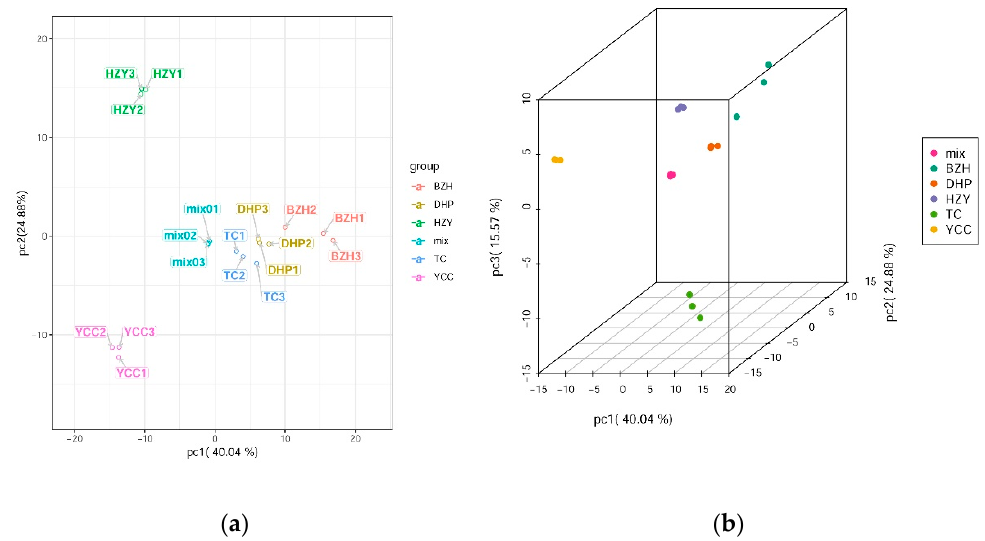
Figure 2. Differential flavonoid metabolite analysis on the basis of principal component (PCA). ( a ) PCA score plot; ( b ) PCA 3D plot.